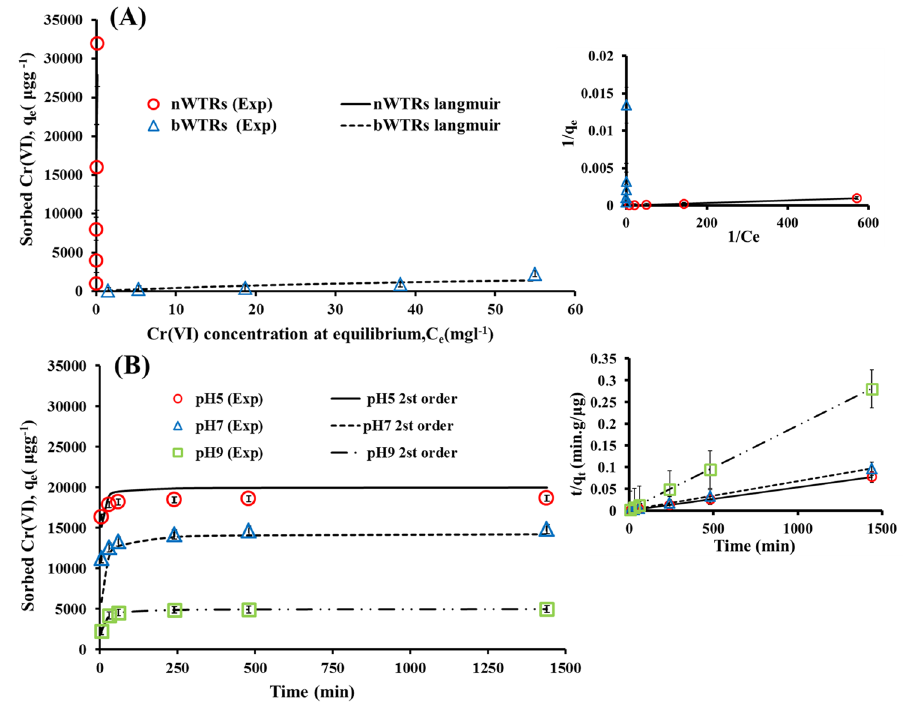
Figure 4. The well fitted adsorption models ( A ) Langmuir and ( B ) Second -order for the Cr(VI) adsorption. The side shows the linear forms of the models (The error bars represent the standard error of mean).